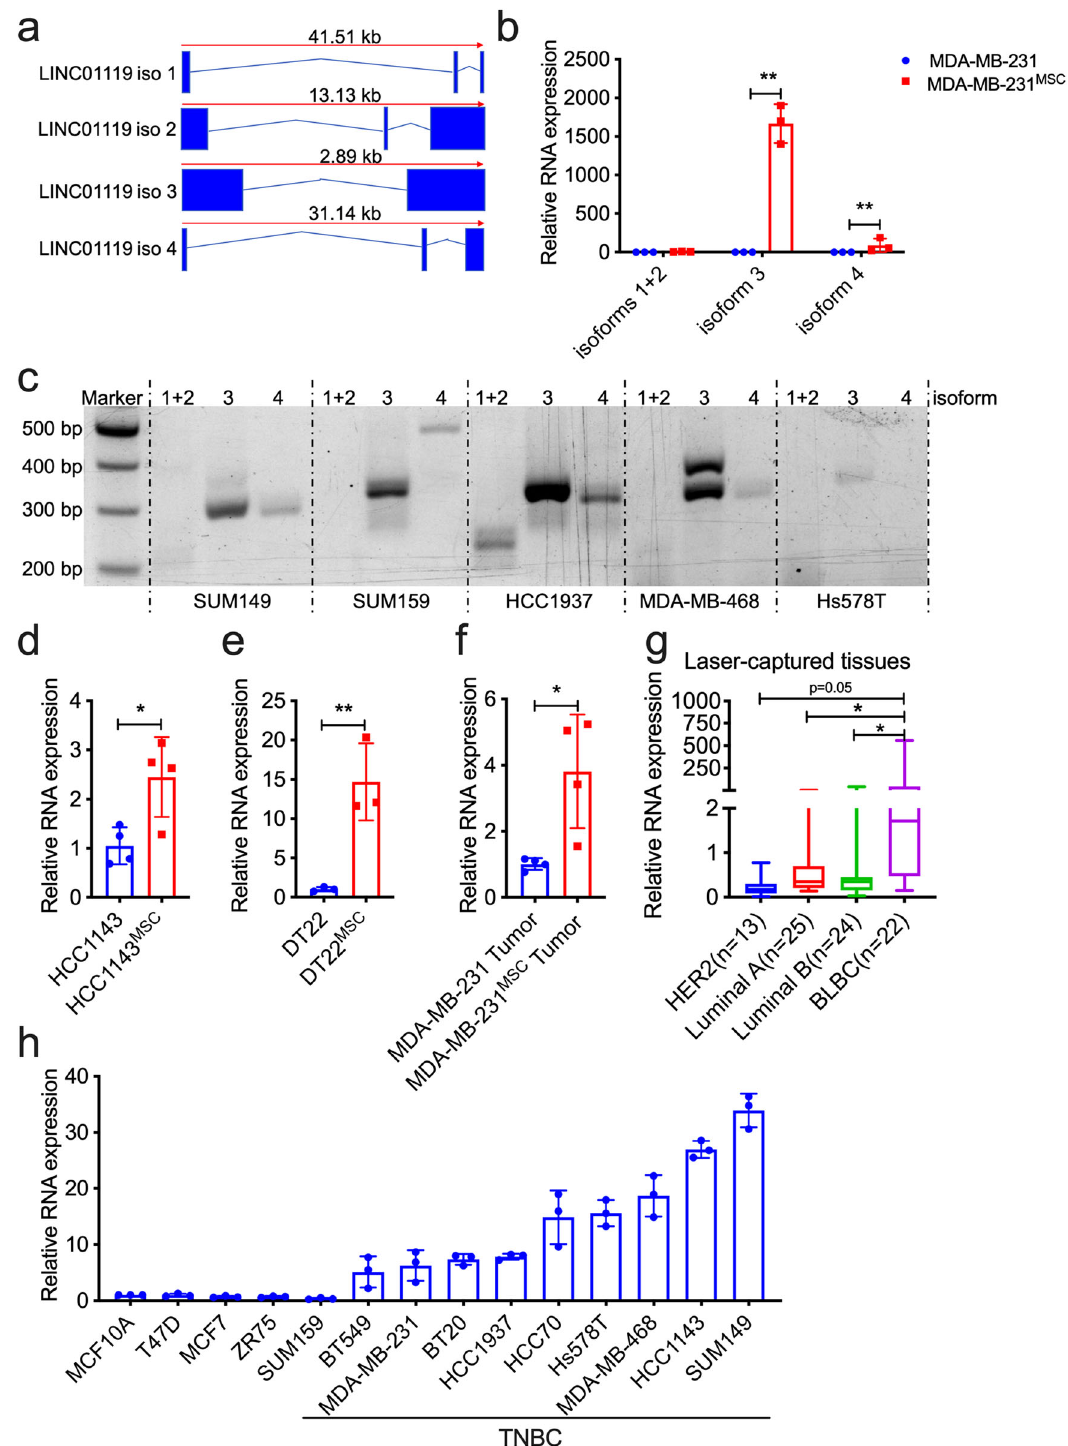
Fig. 2 MSCs speci fi cally upregulate LINC01119 isoform-3 in TNBC cells. a Schematic of LINC01119 isoforms derived from HUGO database. b qRTPCR measurements (mean ± SD of n = 3) of LINC01119 isoforms in MDA-MB-231 MSC versus controls. c Representative ( n > 3) agarose-gel resolution of semi-quantitative PCR of LINC01119 isoforms in SUM149, SUM159, HCC1937, MDA-MB-468, and Hs578T cells. ( d – f ) qRTPCR measurements (mean ± SD of n > 3) of LINC01119 isoform-3 in HCC1143 MSC versus controls ( d ), in primary DT22 MSC versus controls ( e ), and in MDA-MB-231 cells recovered from human-MSC-containing tumor xenografts ( f ). g LINC01119 isoform-3 qRTPCR on dissected cancer cells lifted off slides of the indicated tumor samples. Box-and-whisker plots represent the median (centerline) and inter-quartile range (IQR; box). The whiskers extend up to 1.5 times the IQR from the box to the smallest and largest points. Normal breast tissue was used as a control. h LINC01119 expression (mean ± SD of 2 − ΔΔ CT ; compared with MCF10A; n = 3) in indicated breast cancer cells. LINC01119 levels were normalized to 18